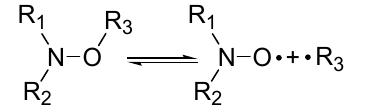
Scheme 1. Reversible C—ON bond homolysis in alkoxyamines.